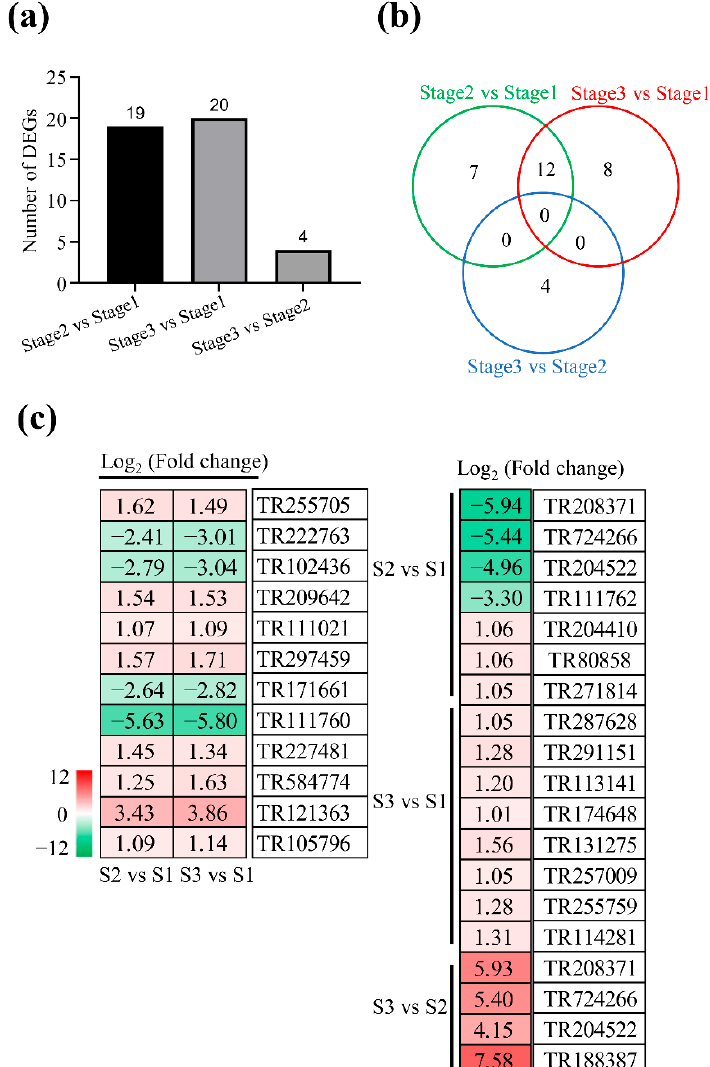
Figure 5. Analysis of differentially expressed genes involved in lipid metabolism. ( a , b ) Summary of differentially expressed genes at stage 1, stage 2, and stage 3. ( c ) The list of differentially expressed genes. Red and green represent up-regulated and down-regulated, respectively.